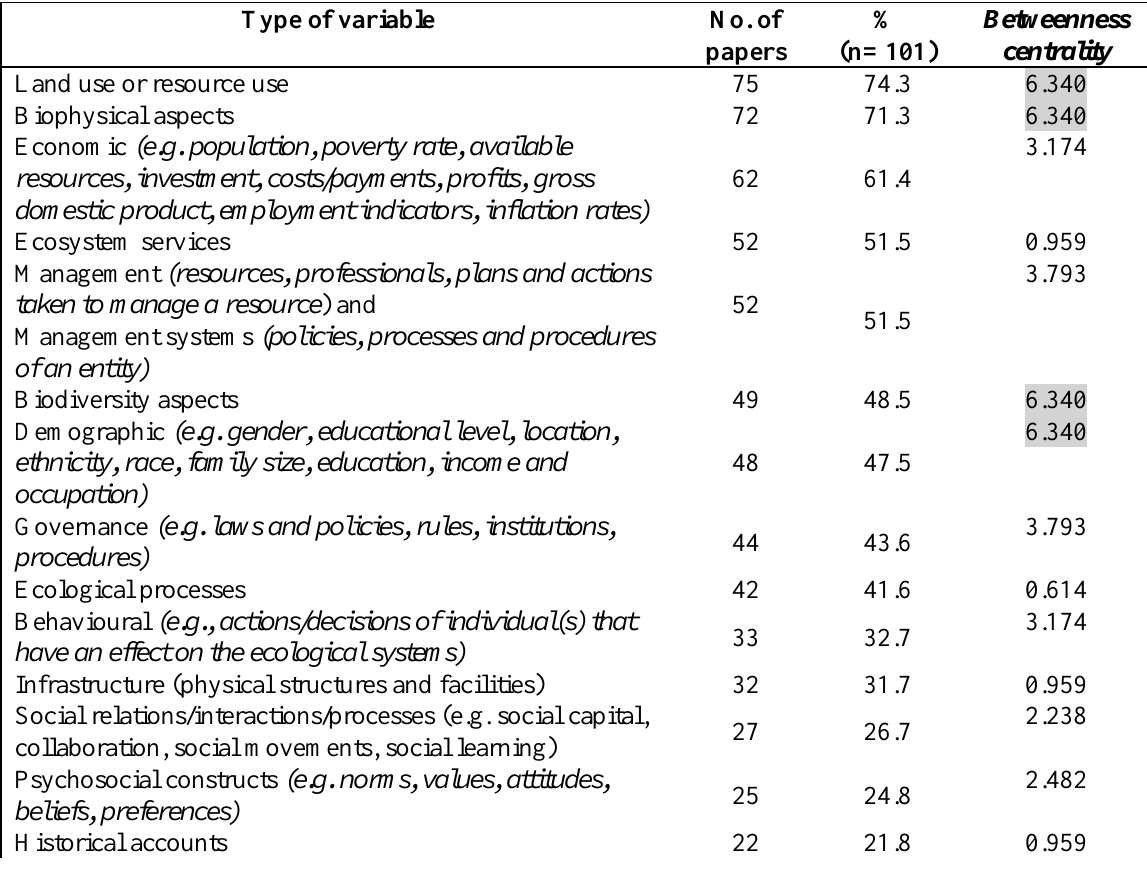
Fig. A4.1 Relative frequency distribution of integration score (n=101). Likert scale from 1 (minimal integration) to 5 (very well integrated). Table A4.1 Representation of different types of social and environmental variables in empirical papers and betweenness centrality scores. High betweenness centrality scores are highlighted in grey, indicating the variables that are more commonly integrated with other